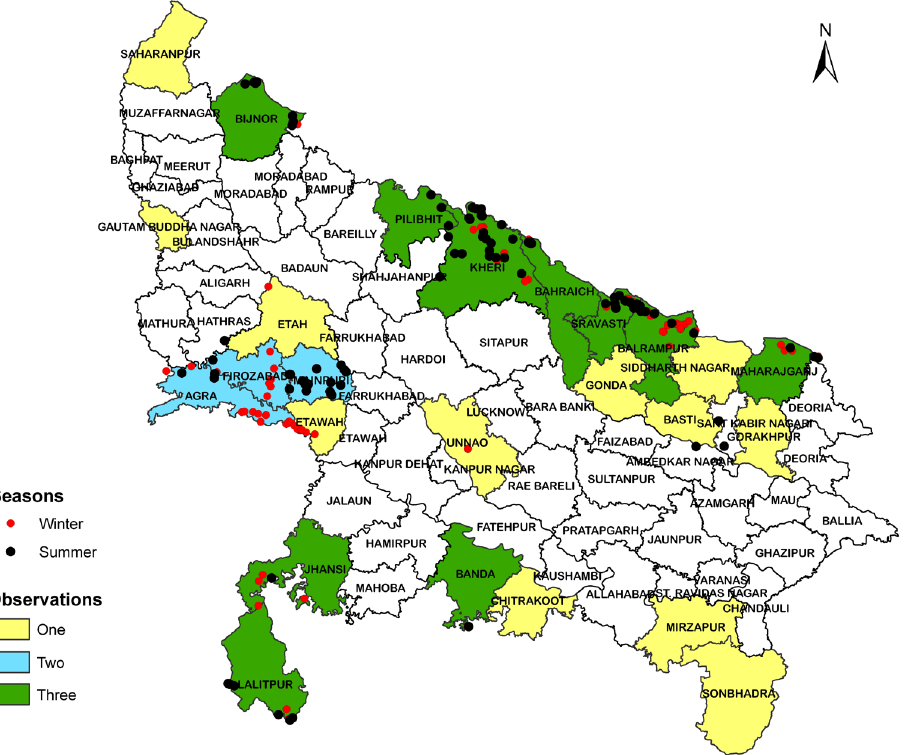
Figure 2. Vulture sighting frequency (coloured polygons are the districts of vulture occurrence). Coloured dots are the GPS data based vulture locations